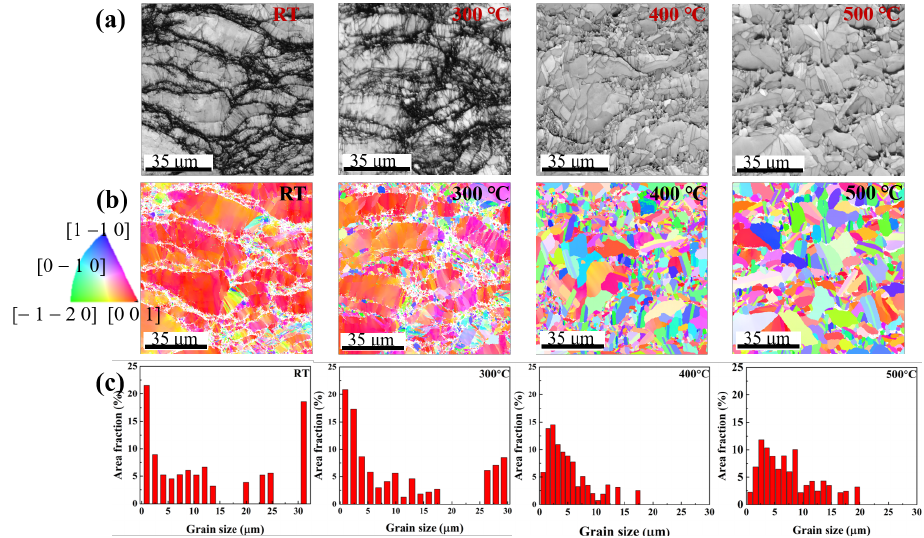
Figure 5. EBSD data with ( a ) IQ map, ( b ) color-coded IPF map, and ( c ) grain size distribution at RT, 300, 400, and 500 ◦